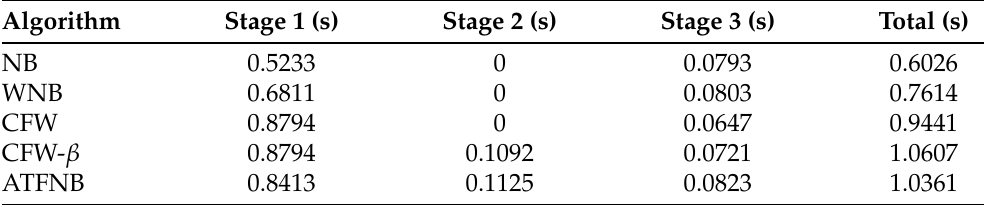
Table 16. The computation time of each stage for various algorithms on the blood dataset (in seconds).